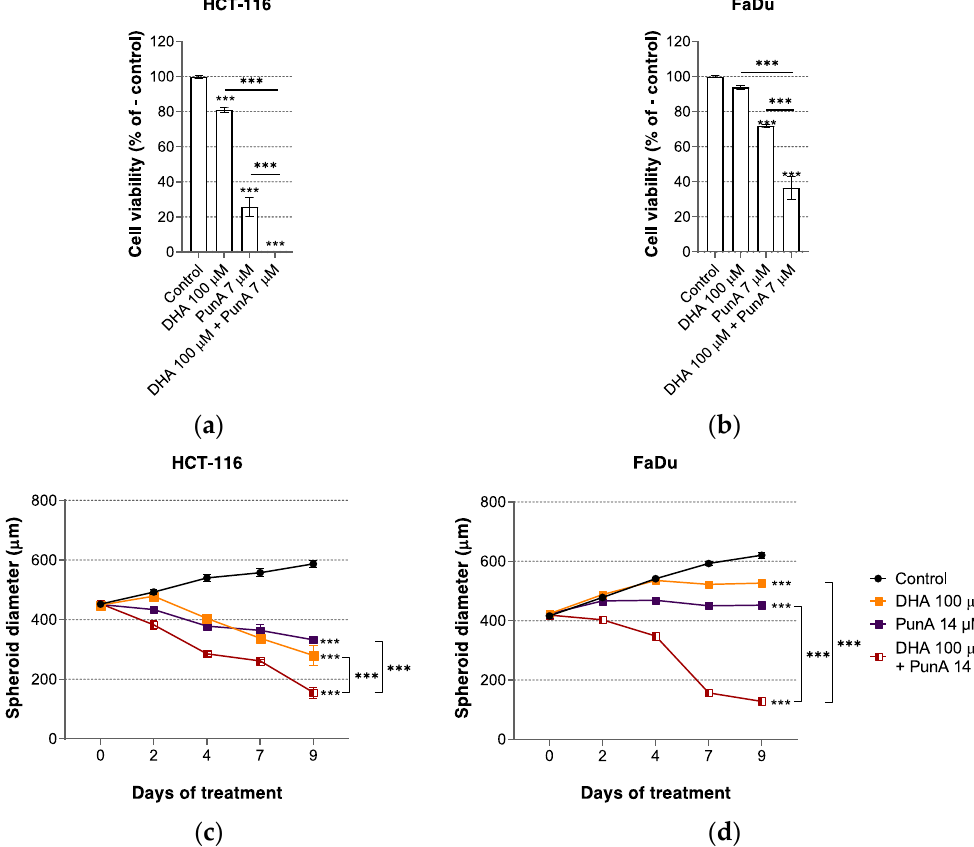
Figure 2. Combining punicic acid (PunA) with docosahexaenoic acid (DHA) increases its cytotoxicity on HCT-116 and FaDu carcinoma cells. ( a ) Viability of HCT-116 and ( b ) FaDu carcinoma cells treated with DHA, PunA or combination thereof. ( c ) Diameter growth of HCT-116 and ( d ) FaDu 3D spheroids treated with PunA 14 µ M, DHA 100 µ M or combination thereof. Control: cells or spheroids supplemented with DMEM cell culture medium without added fatty acid(s). Results are expressed as mean ± standard error of the mean of three independent repetitions. Significance is established in relation to the control or between DHA or PunA alone and their combination. *** p ≤ 0.0001.